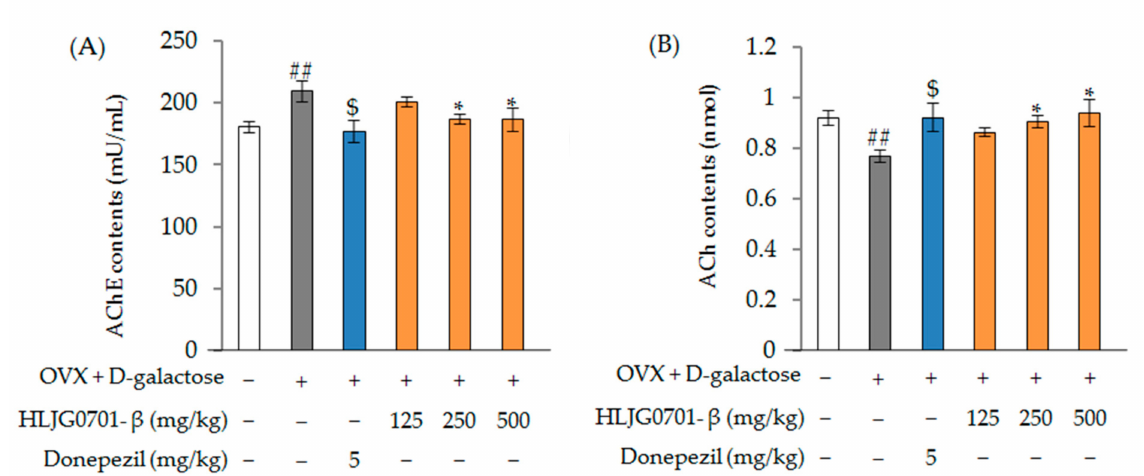
Figure 9. Effect of HLJG0701- β on the contents AChE ( A ) and ACh ( B ) in mice brain tissue. Data are presented as mean ± standard deviation. Error bar: standard deviation. ##, significant difference compared with control by Student’s t -test, p < 0.01; $, significant difference compared with OVX + D -galactose group by Student’s t -test, p < 0.05; *, significant difference compared with OVX + D -galactose group by one-way ANOVA, p <